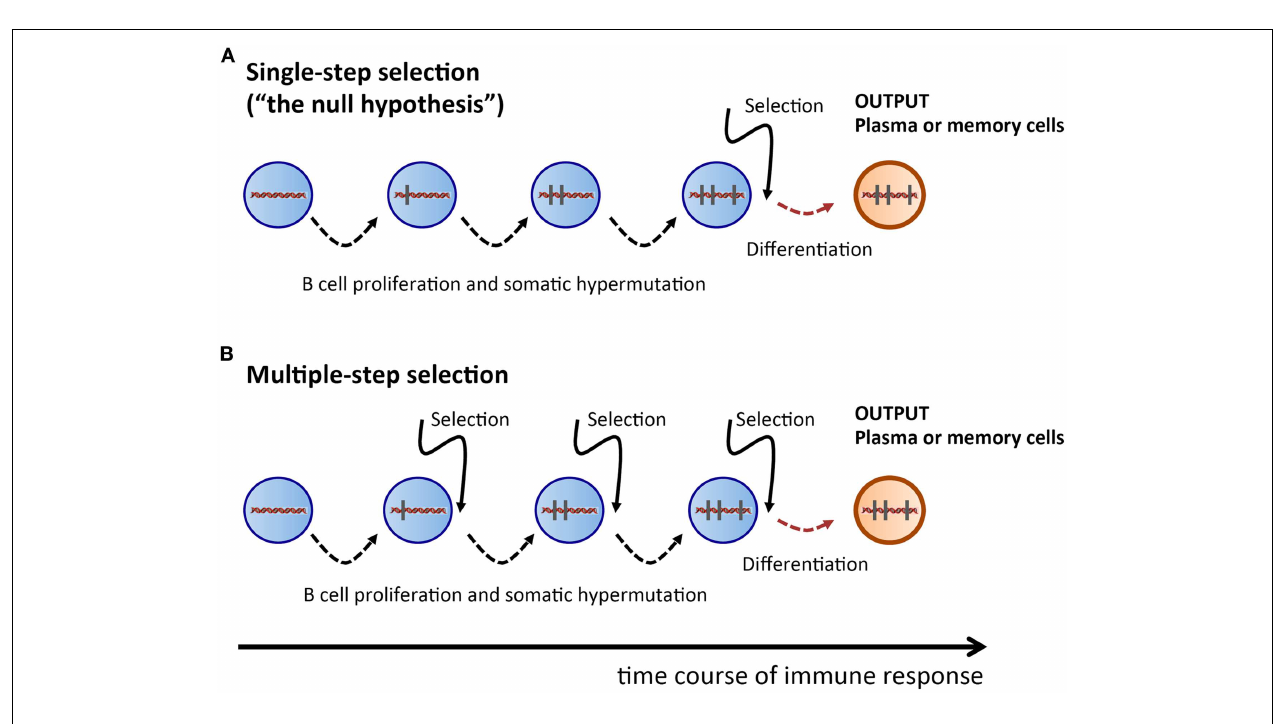
Several alternating rounds of cell division plus mutation and selection [corresponding to several rounds of (A) ], followed by terminal differentiation into a plasma or memory cell after the last selection step. Vertical bars indicate